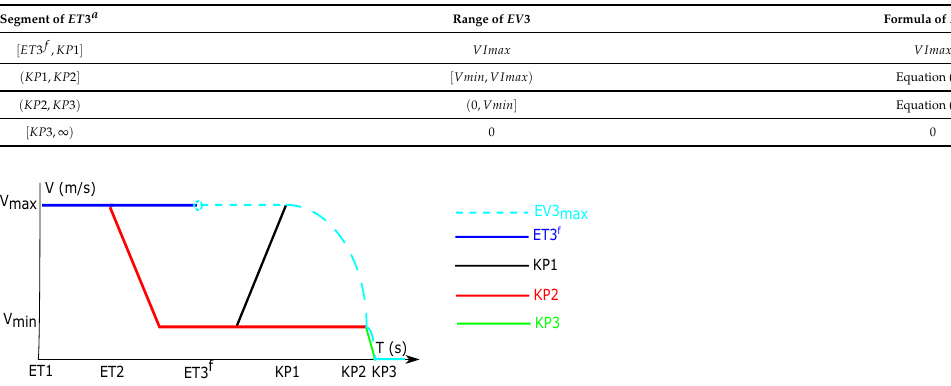
Figure 6. Curve between ET 3 a and maximal EV